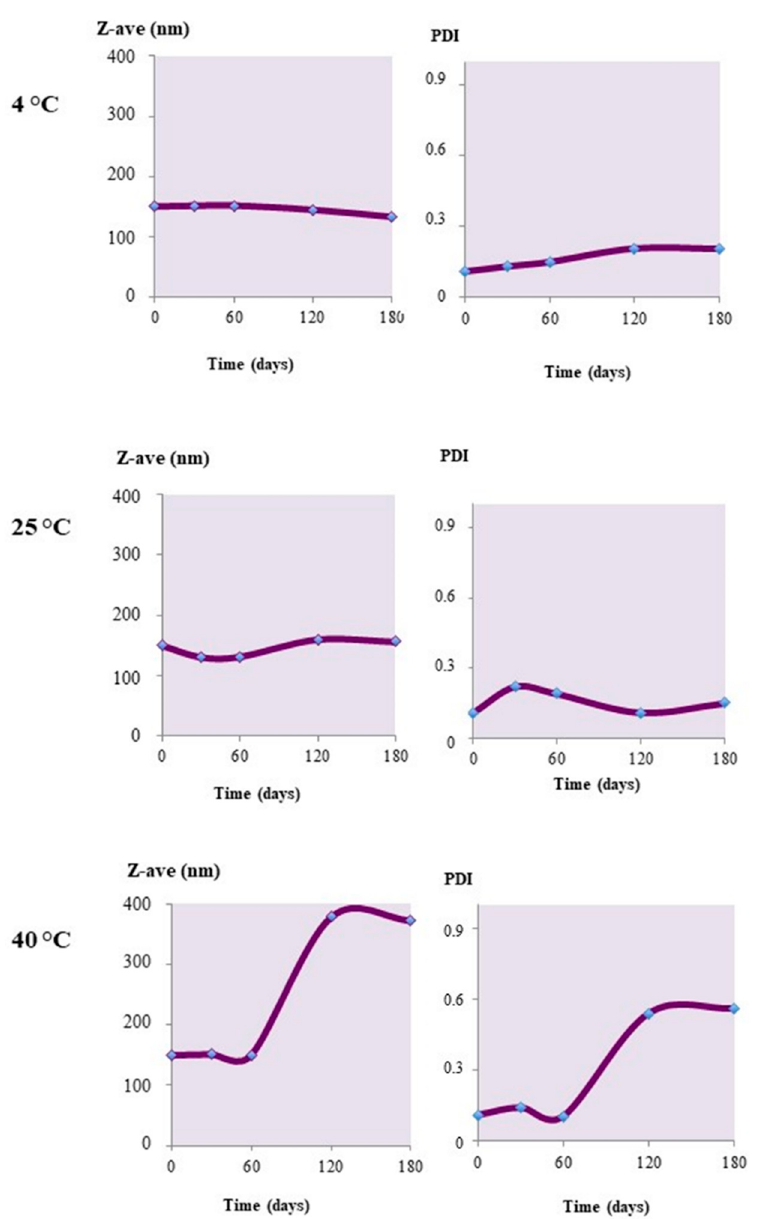
Figure 4. Z-Ave and PdI changes upon the storage of unloaded Uns-PHA nanoparticles at different temperatures.